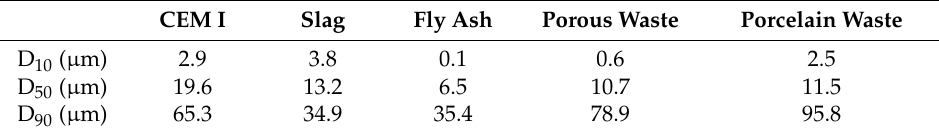
Table 2. Particle size distributions of the di ff erent materials studied. CEM I Slag Fly Ash Porous Waste Porcelain